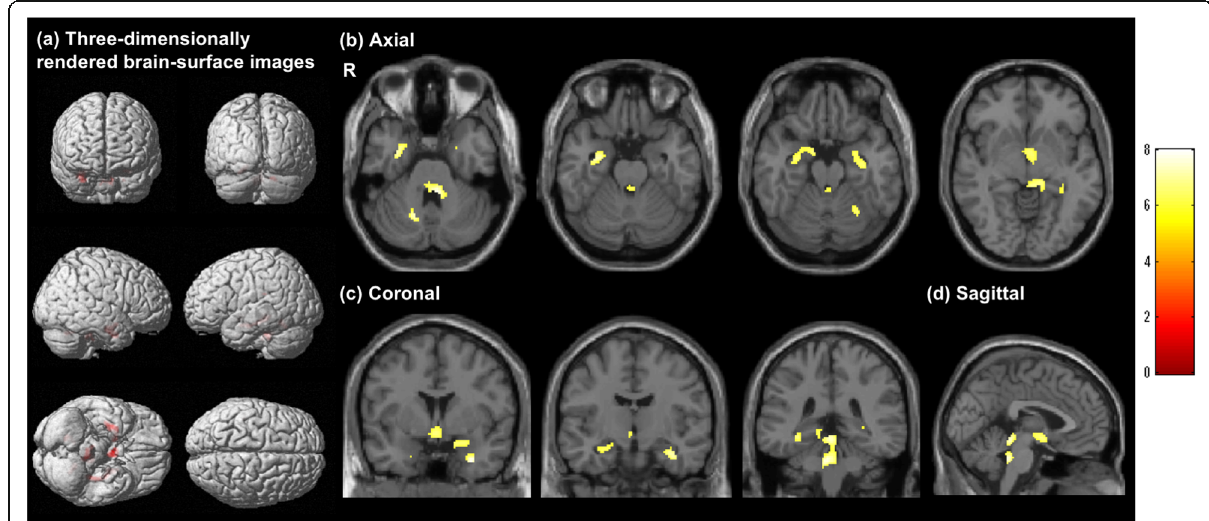
Fig. 1 Voxel-wise analysis of [ 18 F]FDG standardized uptake value ratio images ( p < 0.05, family-wise error corrected). Regions with a significant reduction of [ 18 F]FDG standardized uptake value ratio (SUVR) are highlighted on three-dimensionally rendered brain-surface images ( a ). Axial ( b ), coronal ( c ), and sagittal ( d ) magnetic resonance images show the regions with a significant reduction of [ 18 F]FDG SUVR ( p < 0.05, family-wise error corrected). The color bar denotes the T value (0 – 8). R, right